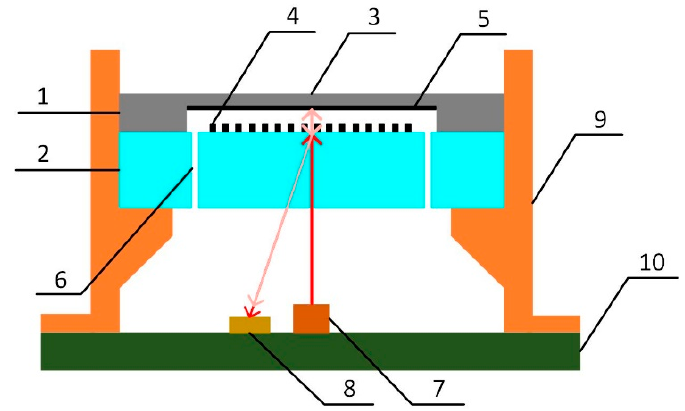
Figure 1. Schematic of the acoustic sensor. 1: Silicon substrate. 2: Glass substrate. 3: Diaphragm. 4: Grating. 5: Reflective layer. 6: Through hole. 7: Laser diode. 8: Photodetector. 9: Housing. 10: Printed circuit